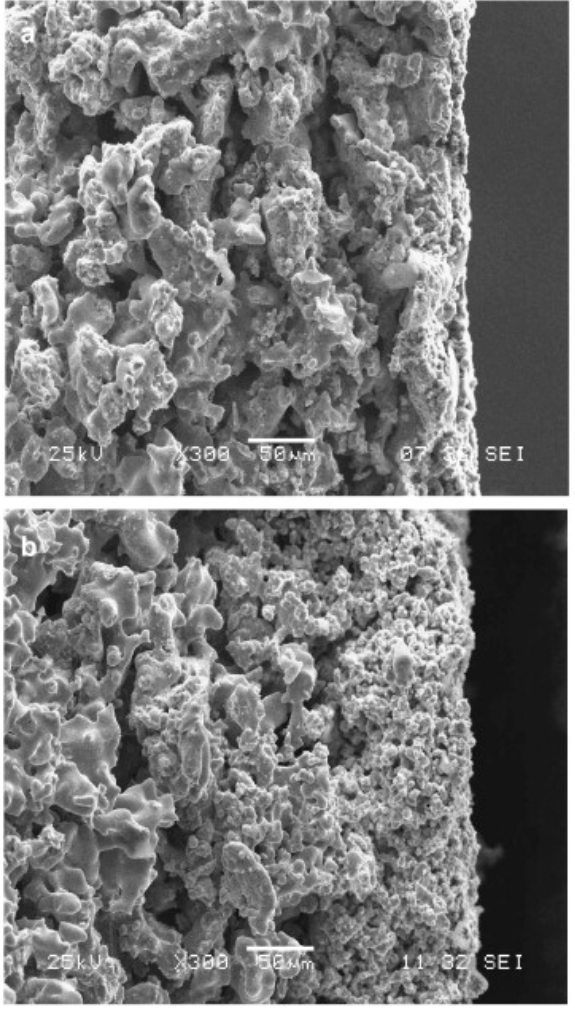
Figure 5. SEM images of cross-section of Fe–Al-alloy supported membranes with different thicknesses: ( a ) 10 µm and ( b ) 120 µm. Reprinted from “Development of a new graded-porosity FeAl alloy by elemental reactive synthesis” [93], © 2009, with permission from Elsevier.